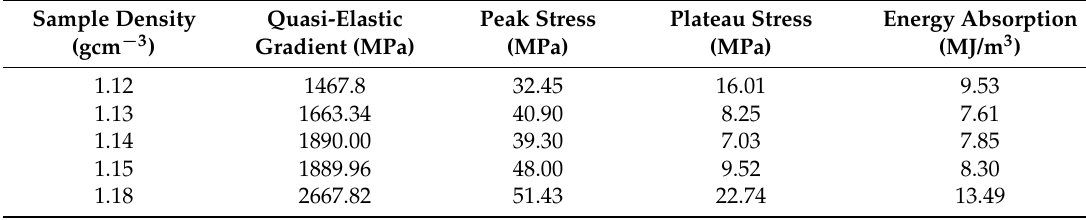
Table 2. Selected Mechanical Properties of the AZ91–AC syntactic foams. Sample